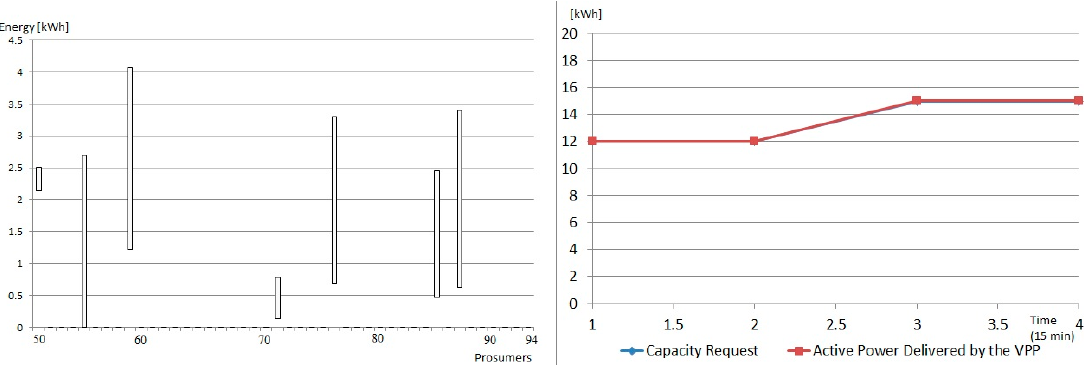
Figure 8. Prosumers in the VPP created in microgrid 2: [LEFT] maximum and minimum energy consumption in the service interval and [RIGHT] Requested capacity vs energy delivered by VPP.